Question: Looking at the figure, what chart type is it?
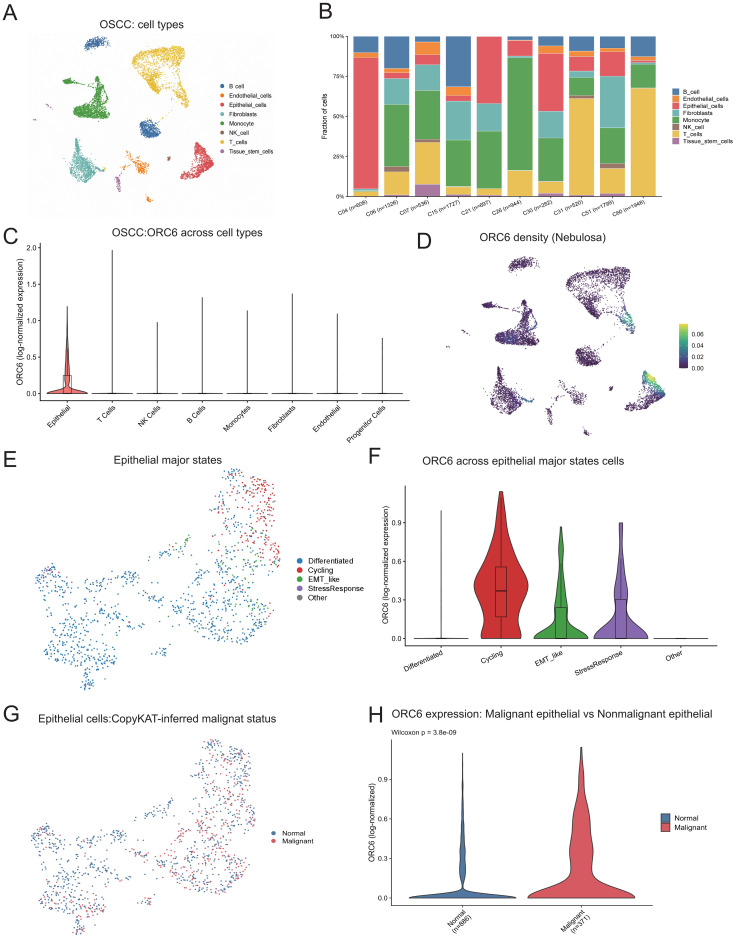
Answer: scatter